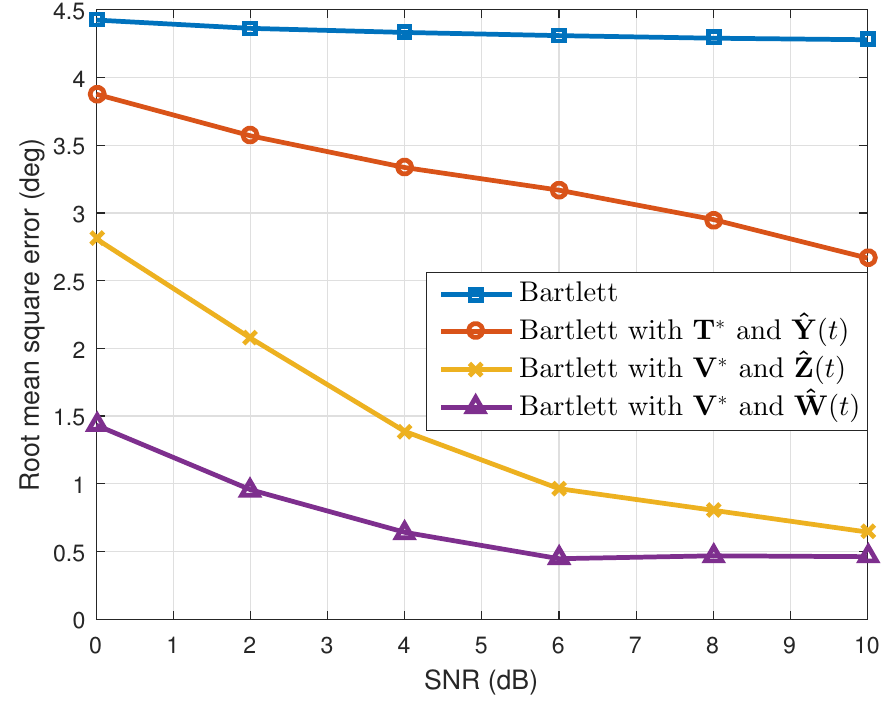
Figure 4. Root mean squared errors versus SNR ( N = 4).